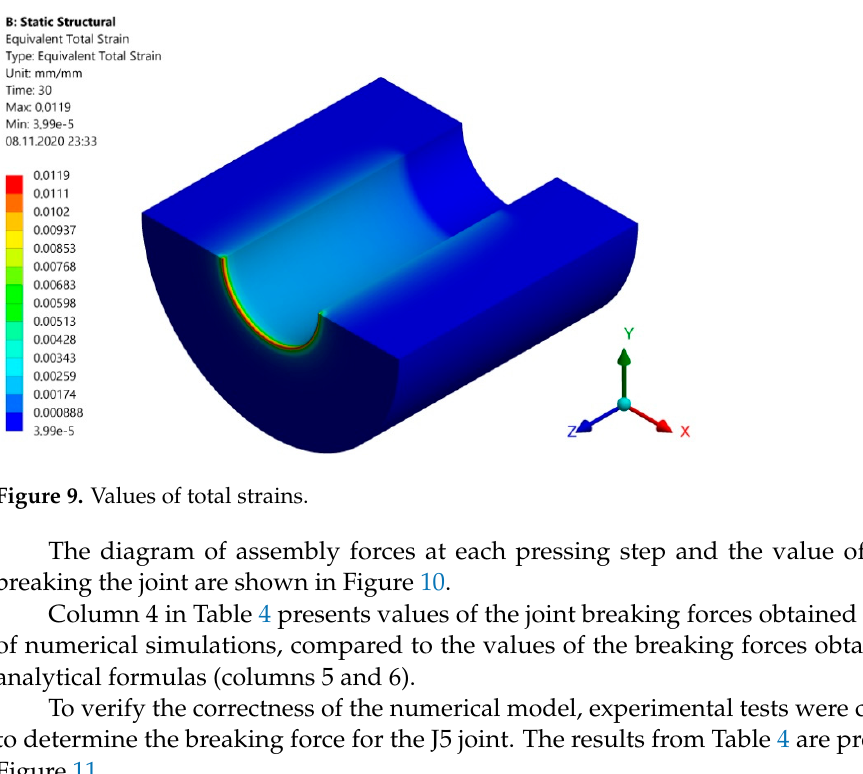
Figure 10. Graphs of assembly forces with marked breaking forces of the J1, J5, J10, and J15 joint. Column 4 in Table 4 presents values of the joint breaking forces obtained as a result of numerical simulations, compared to the values of the breaking forces obtained from analytical formulas (columns 5 and 6).